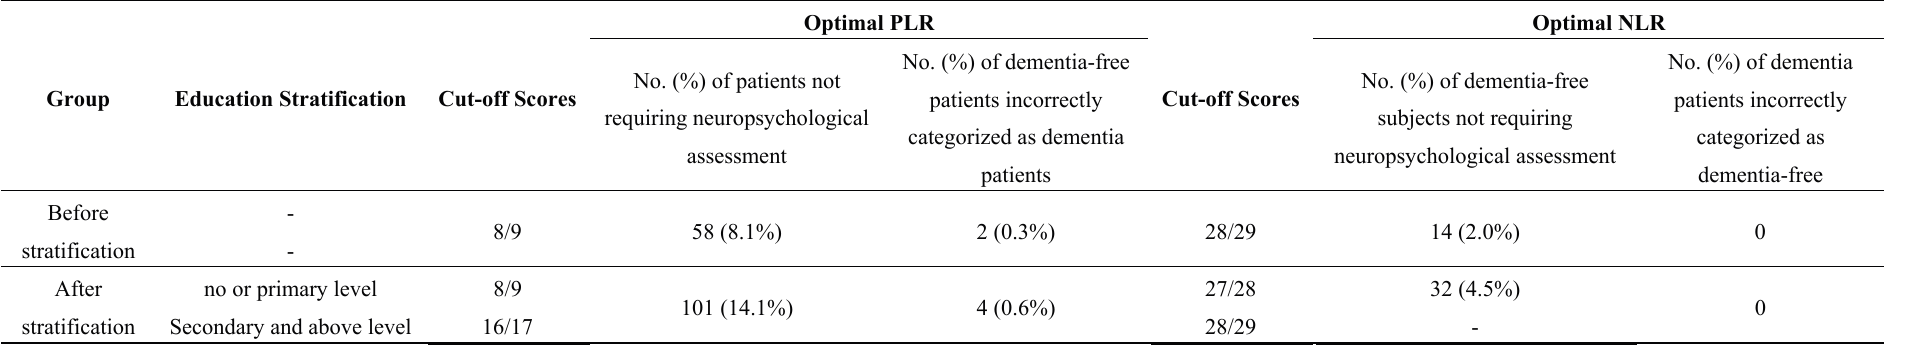
Table 4. Total number (%) of patients who do not need to undergo full neuropsychological assessment, number (%) of dementia-free patients categorized as dementia